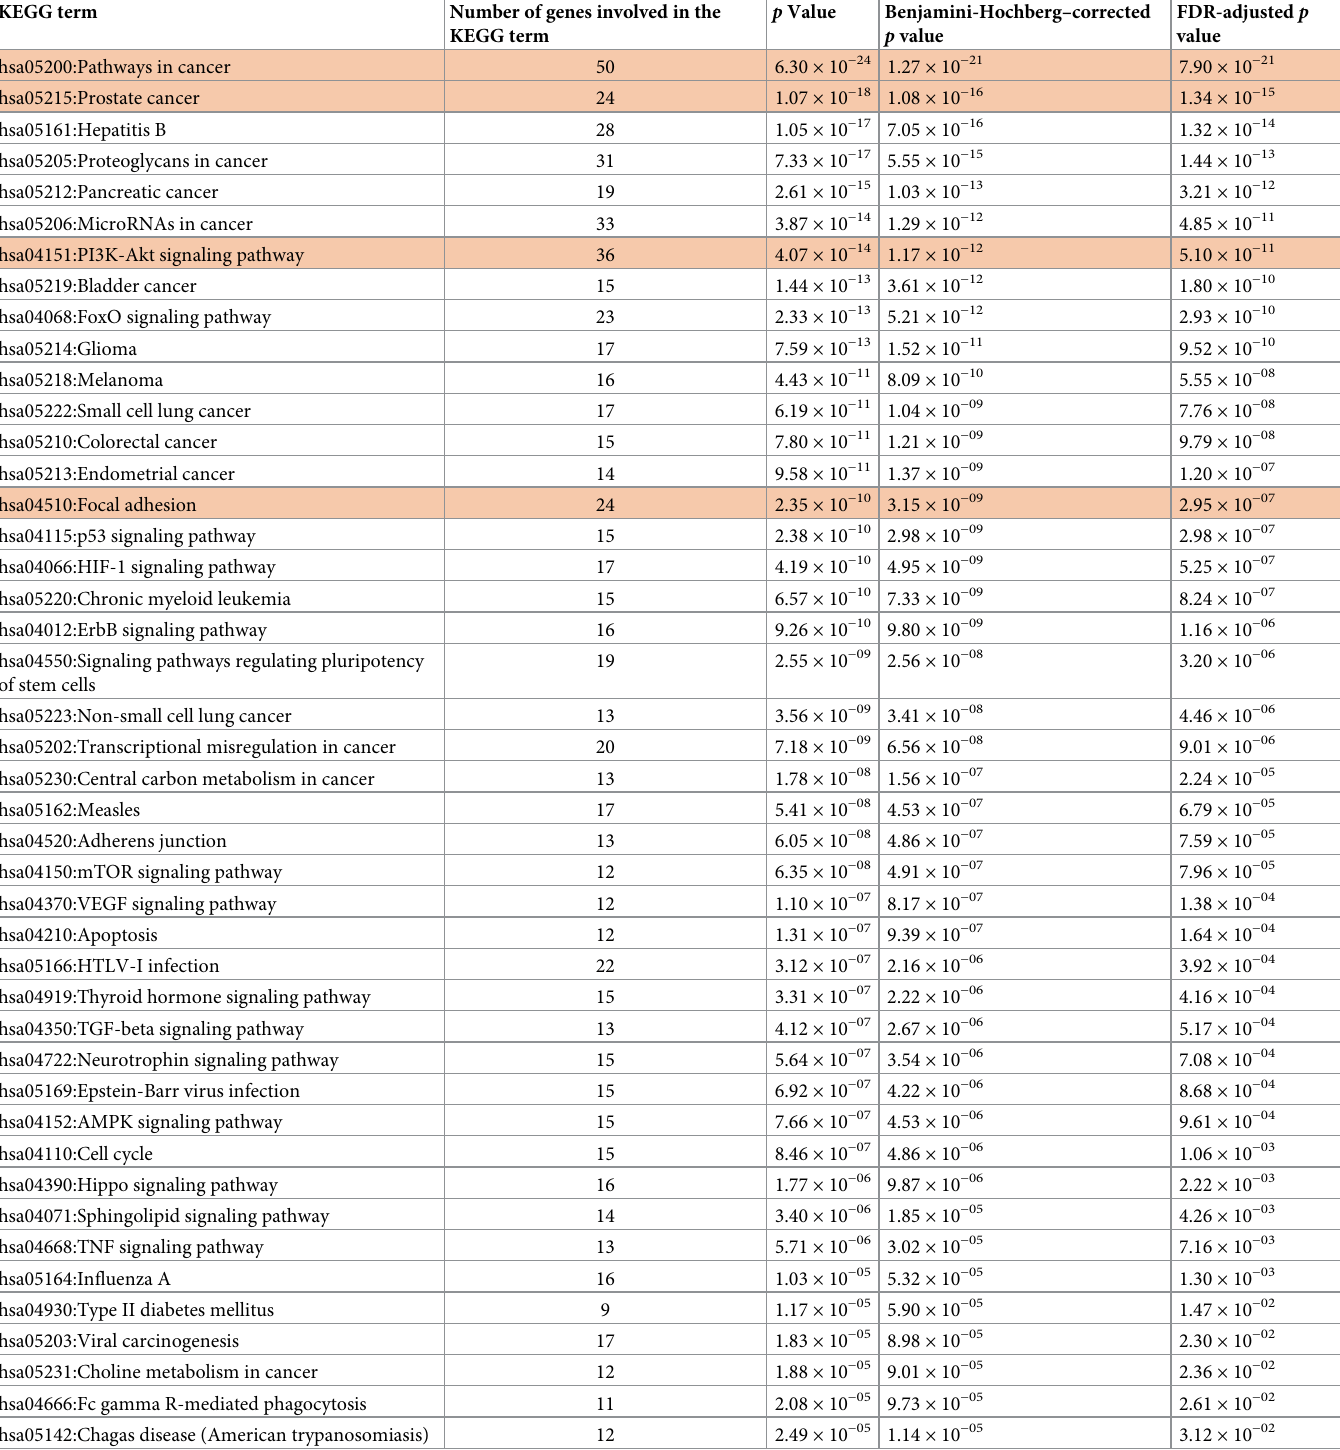
Table 3. Functional annotation of miRNA targets associated with spontaneous term birth. Clustering was performed by DAVID analysis [43] according to KEGG pathways and used all of the identified miRNA targets listed in Table 2. KEGG terms with false discovery rate (FDR)–adjusted p values of < 0.05 are shown. In functional annotation clustering, KEGG terms highlighted in orange comprised the most significant cluster, with an enrichment score of